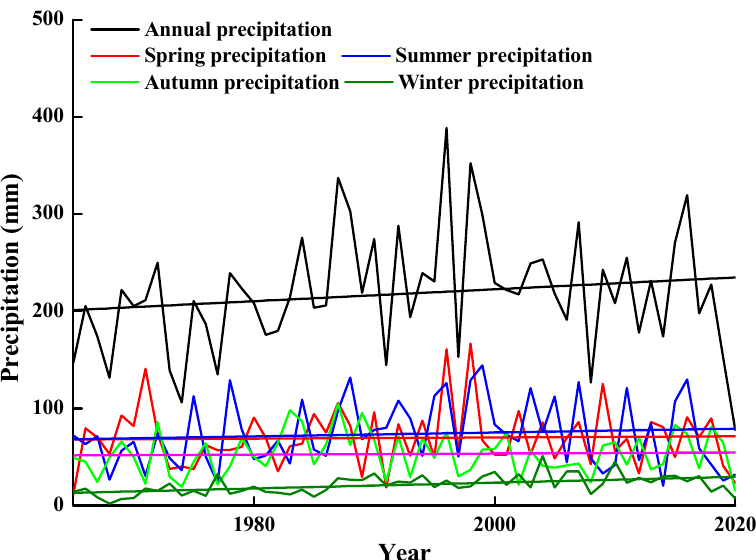
Figure 1. Precipitation at the Fukang weather station in spring, summer, autumn, and winter, 1965– 2020.